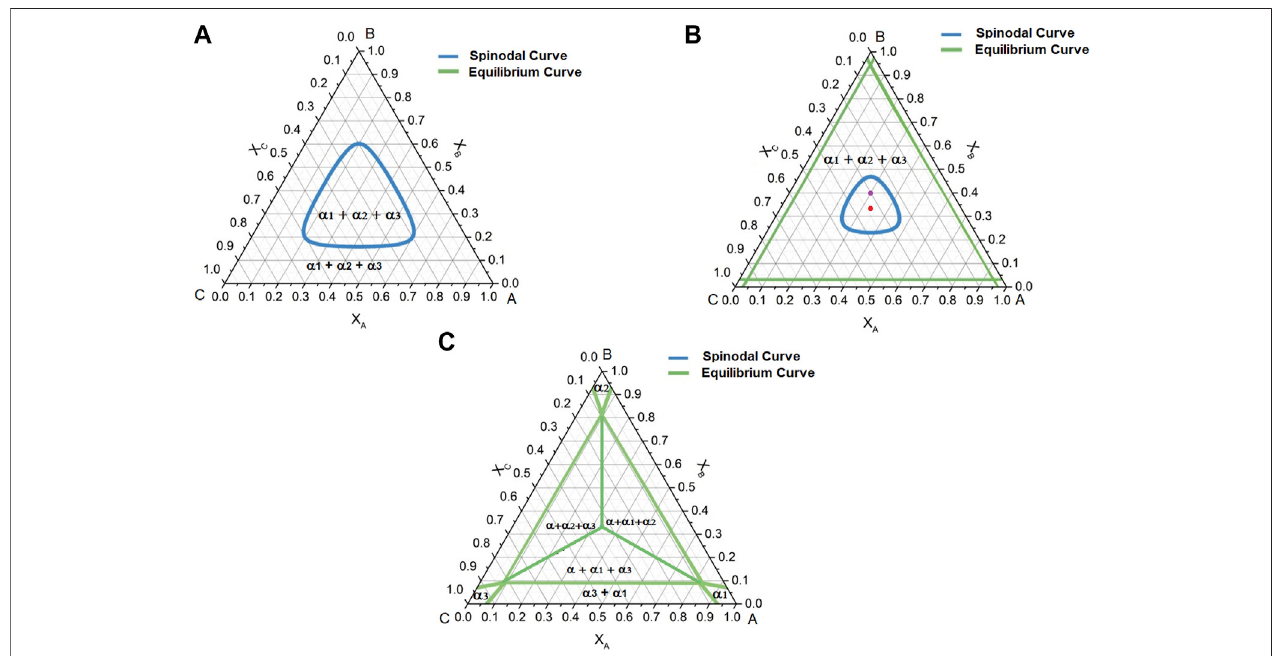
FIGURE2| IsothermalsectionsofthemiscibilitygapandspinodalcurvefortheA – B – Calloysystemwith Ω AB = Ω BC = Ω CA =25,000 J/molat (A) 600 K, (B) 800 K, and (C) 1000 K.